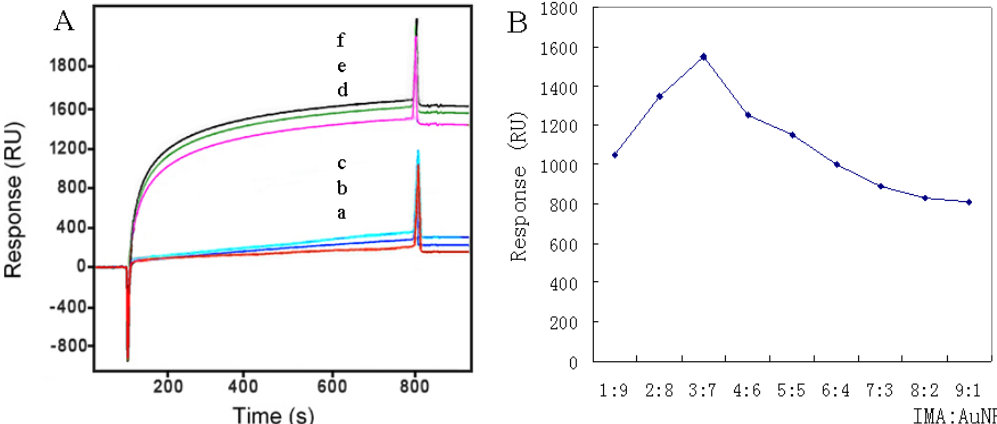
Figure 3. Sensograms showing the bioconjugation yield with different strategies ( A ). IMA concentration of 100 µg/L with three replications from a to c (Format A) and similarly, AuNP enhancement achieved employing IMA from d to f (Format B). The effect of the IMA:AuNP ratios (1:9, 2:8, 3:7, 4:6, 5:5, 6:4, 7:3, 8:2, 9:1) achieved on SPR ( B ), the